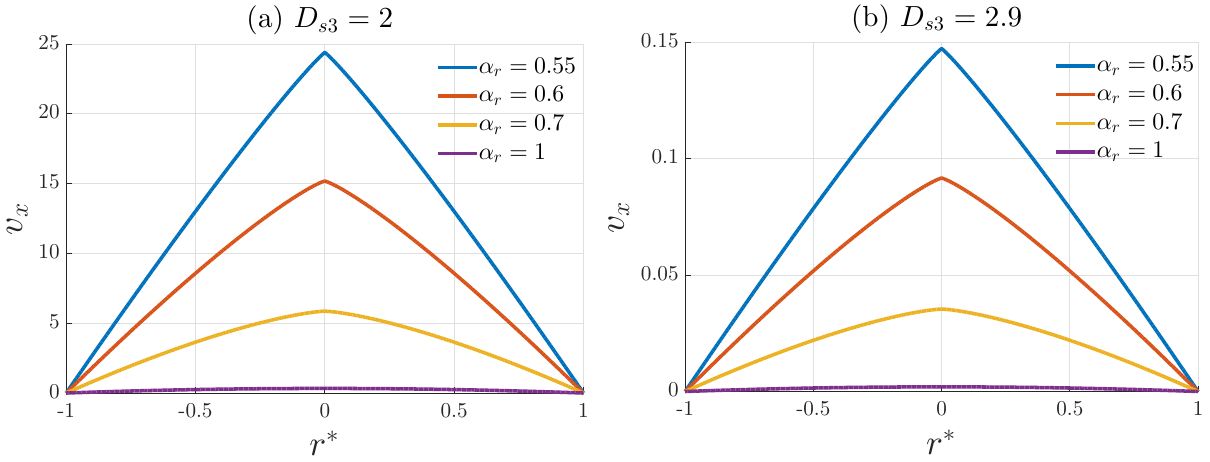
Figure 7. Plots of velocity profiles defined by Equation (28), with r ∗ = r / r e , d x = 0.9, ∆ p = 25 Pa, µ = 10 − 3 Pa.s, and c = 100 m 1 − γ